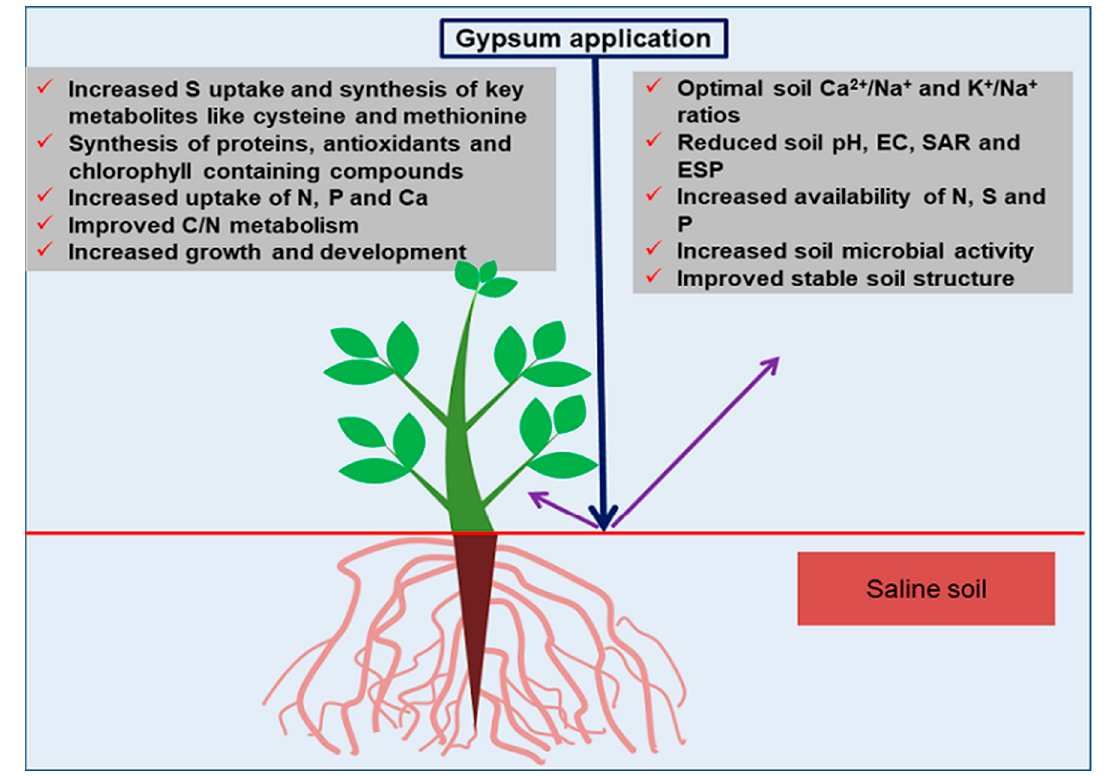
Figure 2. An illustration of the effects of gypsum at the soil–plant interface of a saline